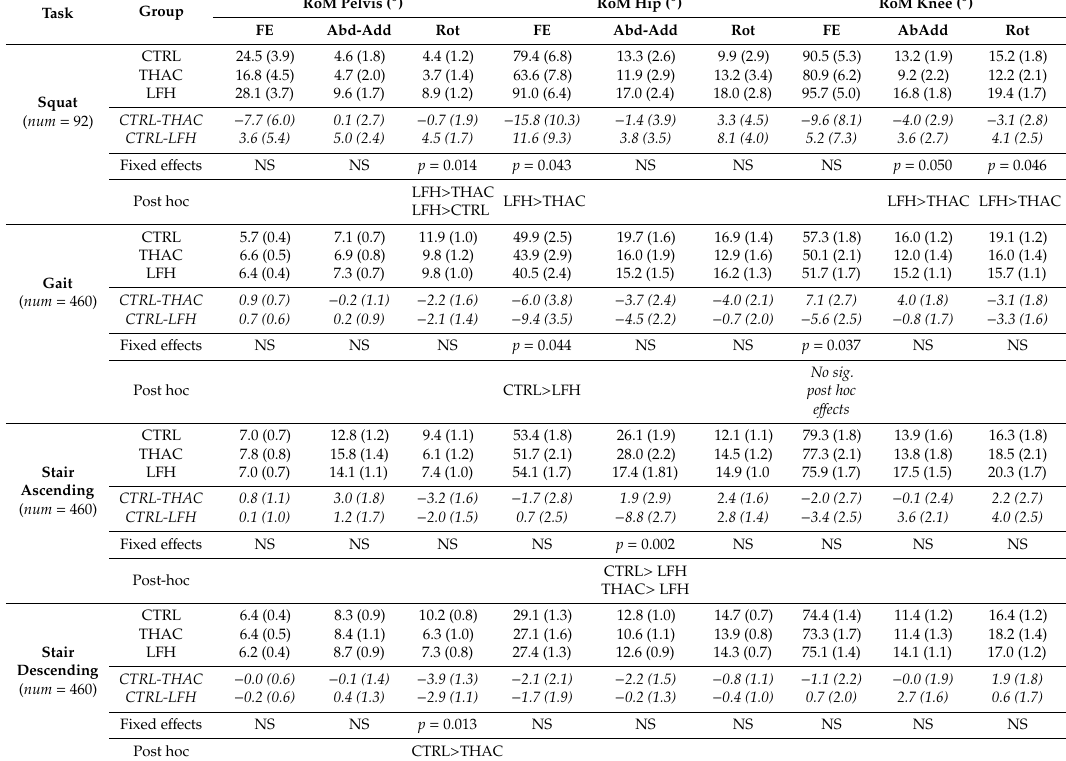
Fixed e ff ects NS NS NS p = 0.044 NS NS p = 0.037 NS